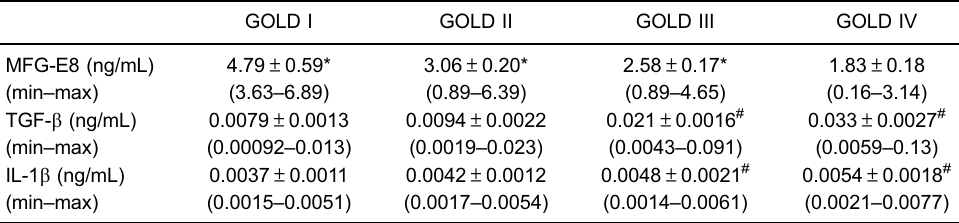
Table 2. Levels of plasma milk fat globule epidermal growth factor (MFG-E8), transforming growth factor (TGF)- b , and interleukin (IL)-1 b in patients with chronic obstructive pulmonary disease differing in severity as measured by the Global Initiative for Chronic Obstructive Lung Disease (GOLD)